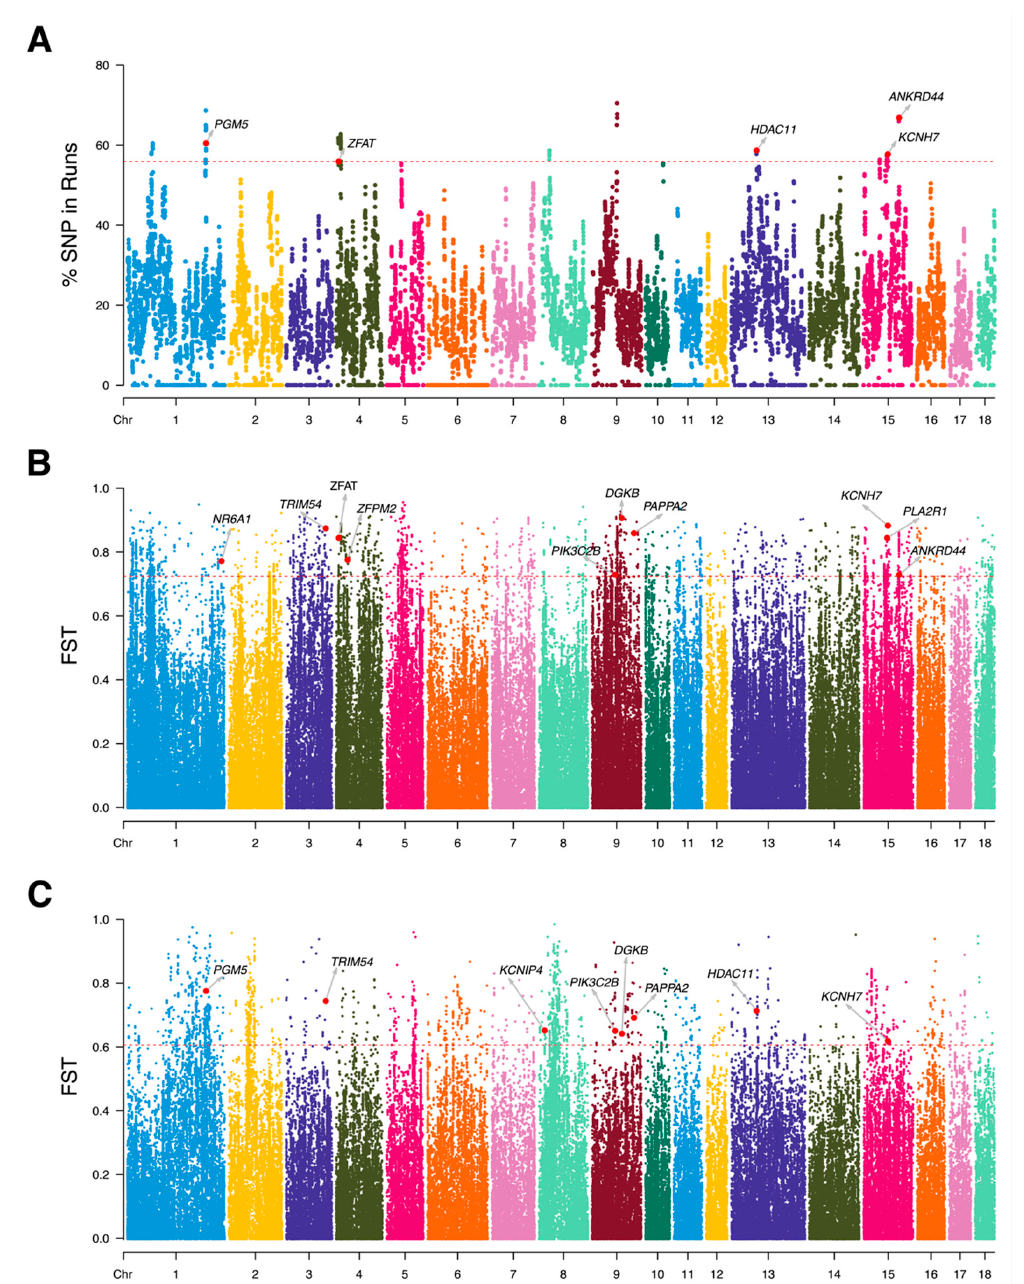
Figure 3. Manhattan plot collection. ( A ) Frequency of occurrences of each SNP within ROH regions in Licha black pig. The x-axis represents the locations of SNPs, and the y-axis represents the percentage of SNPs occurring within ROH regions. ( B ) The distribution of selection signatures between Licha black pigs and the other Chinese pigs was detected by F ST . The x-axis represents the locations of SNPs, and the y-axis represents the F ST values. ( C ) The distribution of selection signatures between Licha black pigs and commercial pigs was detected by F ST . The red line represents the top 1% threshold for statistical significance. Genes related to growth, muscle, and fat have been identi fi ed. We identi fi ed a total of 14,482 haplotype blocks containing 264,823 SNPs in the LI population, which spanned a genomic region of 707,157.385 Kb, as presented in Table S4. The largest number of haplotype blocks (1716) and the longest coverage area (91,328.017 Kb) were found in SSC1, while SSC17 exhibited the least haplotype blocks (382), and SSC12 had the shortest haplotype block coverage chromosome area (14,102.584 Kb). Ad- ditionally, SSC1 contained the largest number of SNPs (32,462) and the highest proportion of SNPs in chromosomes (12.258%). About 147 haplotype blocks with the fi rst 1% of the